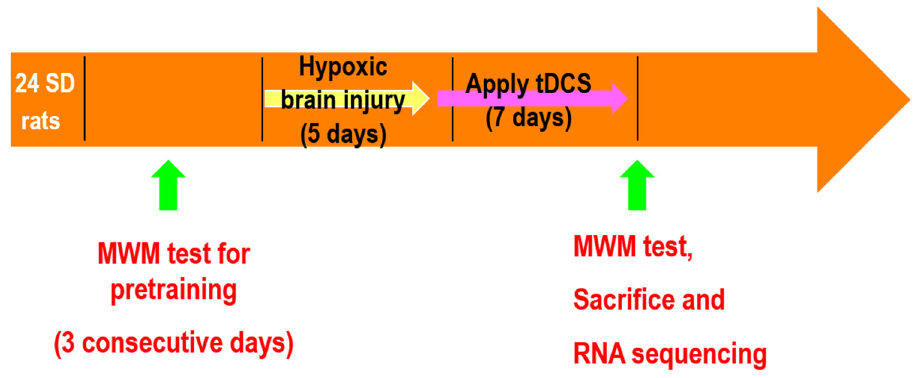
Figure 1. Schematic representation of the experiment.